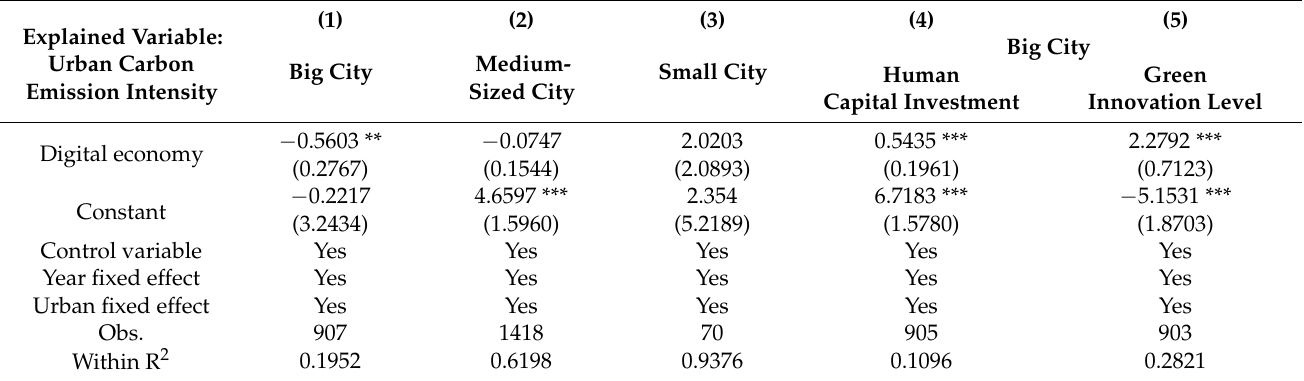
Table 9. Regression results of large, medium and small